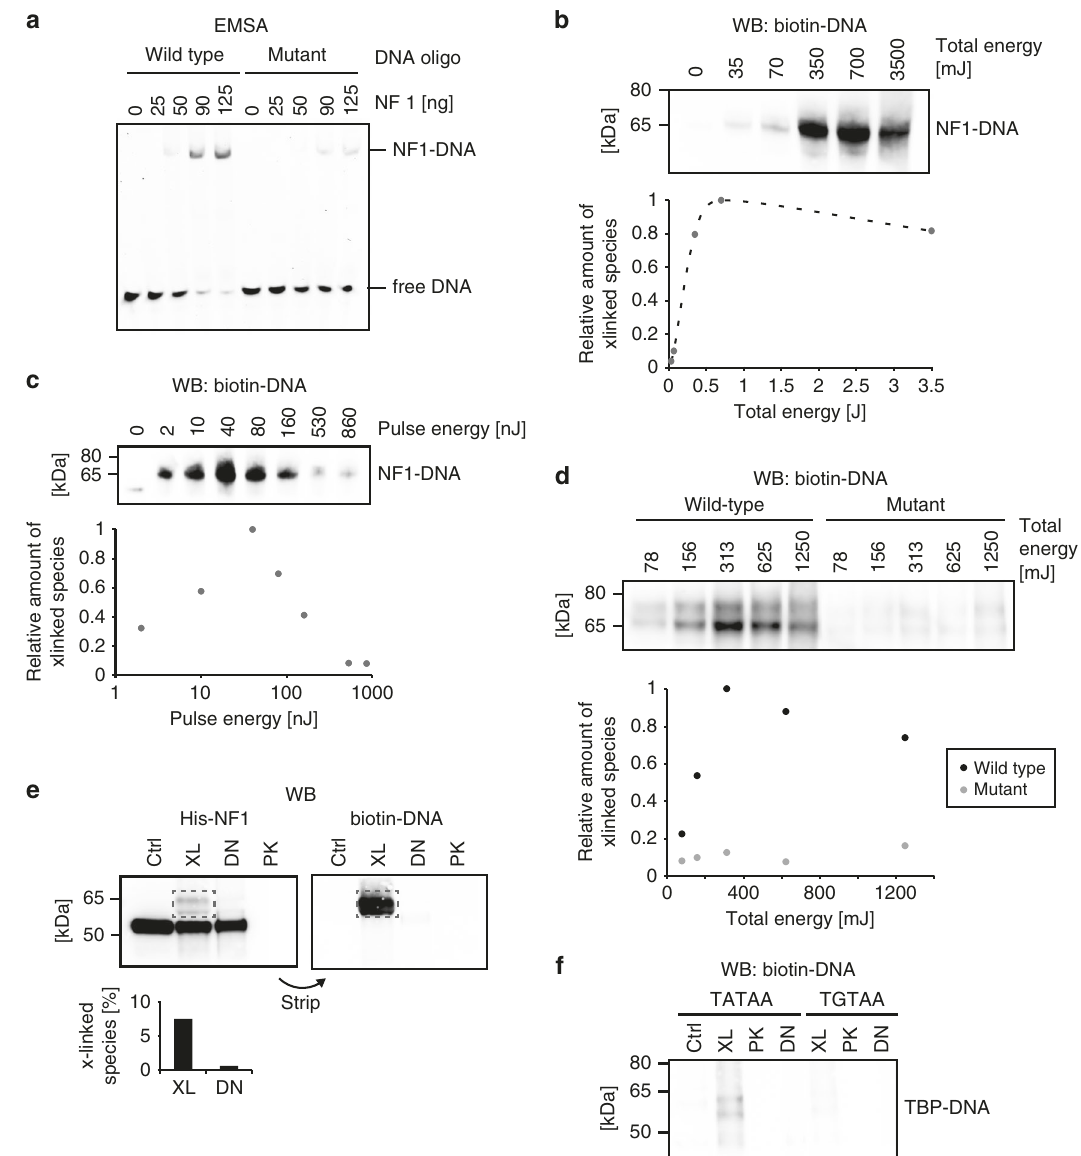
Fig. 2 Assessment of cross-linking ef fi ciencies. a Electrophoretic mobility shift assay (EMSA) with increasing amount of NF1 bound to a DNA oligomer harboring its consensus site, or a mutated version of it. The molar ratios of protein to DNA were 2.1:1 (25 ng), 4.4:1 (50 ng), 8:1 (90 ng), and 11:1 (125 ng). The NF1 – DNA complex was separated from free DNA by nondenaturing gel electrophoresis and visualized by SYBR Green staining. b NF1 – DNA (5 ′ - biotinylated) complex was irradiated with increasing total energy and constant pulse energy of 7 nJ. Samples were separated by denaturing gel electrophoresis, protein – DNA complexes transferred to a nitrocellulose membrane, and biotinylated DNA visualized by probing with an HRP-coupled streptavidin conjugate. Intensities of the cross-linked protein – DNA bands (x-linked species) were quanti fi ed and plotted relative to the most intense band at 700 mJ. c NF1 – DNA (5 ′ -biotinylated) complex was cross-linked applying increasing pulse energies, and a constant total energy of 1 J. Cross-linked protein – DNA complexes were detected as in b . Band intensities were plotted relative to the most intense band at a pulse energy of 40 nJ. d NF1 bound to a DNA oligo harboring its consensus site or a mutated version of it was irradiated with increasing total energy and constant pulse energy of 50 nJ: cross- linking depended on a functional protein – DNA interaction. e NF1 – DNA complex was cross-linked with a pulse energy of 7 nJ and 350 mJ total energy (XL) or left untreated (Ctrl). Cross-linked samples were further optionally treated with DNase I (DN) or proteinase K (PK) and loaded on a SDS-PAGE followed by western blotting. After detection of His-NF1 using an anti-His antibody, the membrane was stripped and reprobed with an HRP-coupled streptavidin conjugate to detect biotin-labeled DNA. The percentage of cross-linked protein – DNA complexes (x-linked species) was calculated as the intensity of the cross-linked band (dashed rectangle) divided by the sum of intensities of all bands observed in the cross-linked sample. f TBP bound to DNA oligos containing either a wild-type (TATAA) or point-mutated (TGTAA) consensus motif were UV irradiated (pulse energy 50 nJ, total energy 1.25 J) and biotin- DNA detected by western blot. Full-scale versions of all blots are depicted in Supplementary Fig.